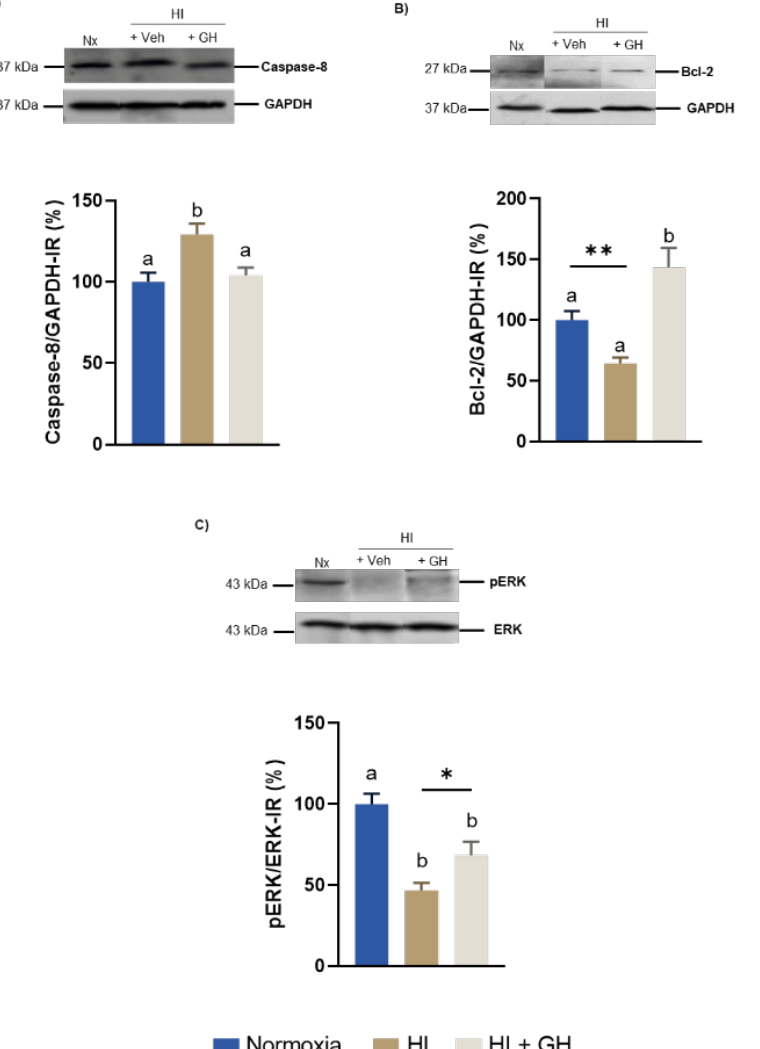
Figure 2. Effects of growth hormone (GH) upon modulation of apoptotic and pro-survival (caspase- 8, Bcl-2, ERK1/2) pathways in the pallium of chick embryos exposed to a hypoxic–ischemic (HI) injury. ( A ) Densitometric analysis of immunoblots stained for Caspase-8 immunoreactivity-IR. ( B ) Densitometric analysis of immunoblots stained for Bcl-2 IR. In both cases, the values were corrected and normalized with GAPDH IR. ( C ) Densitometric analysis of immunoblots stained for pERK1/2 IR (corrected and normalized to total ERK1/2 IR). Bars represent mean ± SEM ( n = 5 chick embryos per group). Groups with different letters are significantly different by one-way ANOVA with Tukey’s post hoc test ( p < 0.01). An unpaired Student’s t test was used to compare normoxia versus HI + GH (panel B ), and HI versus HI + GH groups (panel C ). Asterisks (*) indicate significant differences (* p < 0.05, ** p <